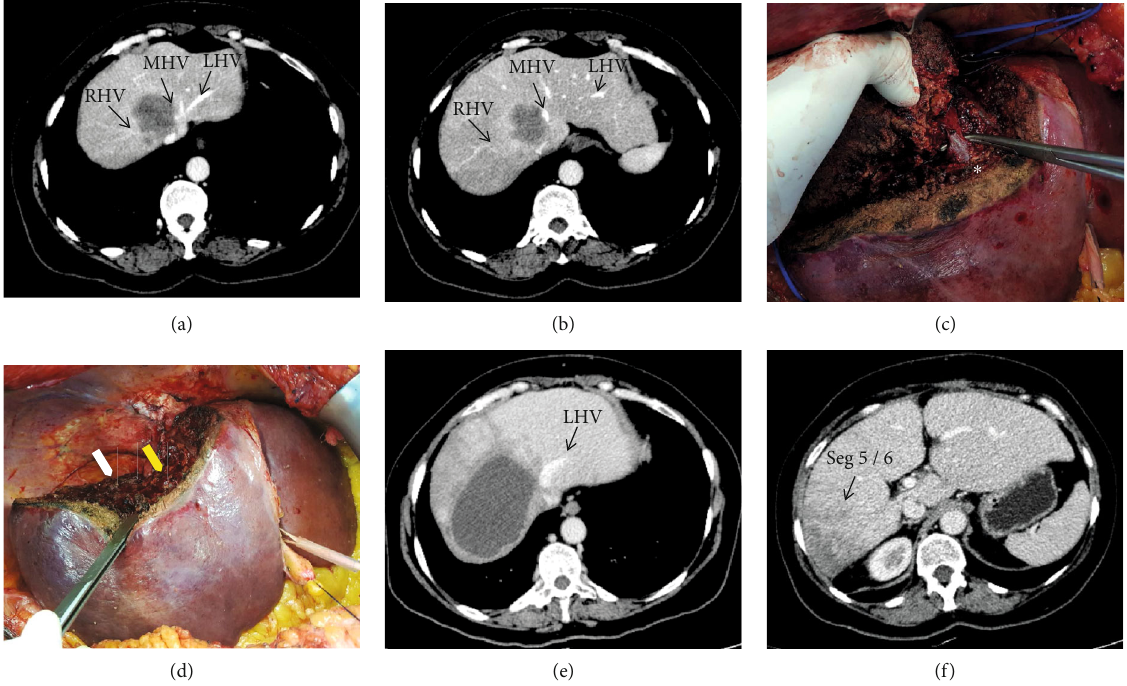
Figure 5: (Patient 4) (a, b) Colorectal liver metastasis with right and middle hepatic veins invasion. (c) Middle hepatic vein isolation (asterisk) during liver transection. (d) Immediate postoperative aspects of the liver with proximal right and middle hepatic vein ligature (white and yellow arrows, respectively). (e) Left hepatic vein draining remnant liver segments. (f) Postoperative segments 5 and 6